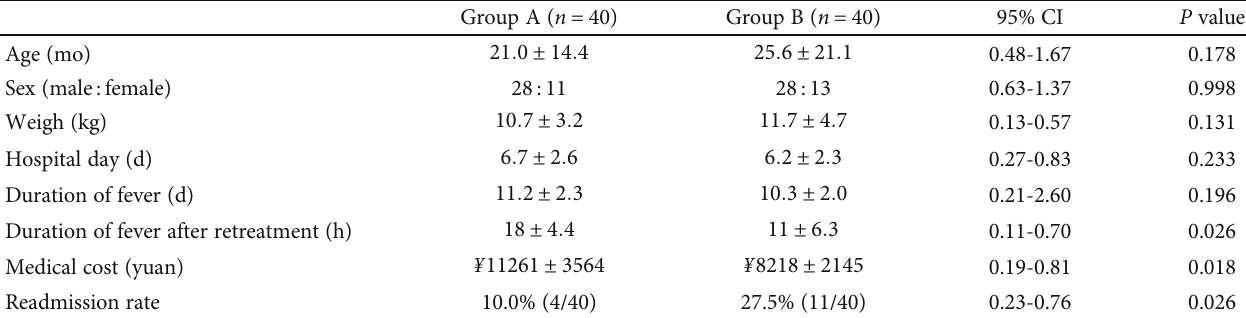
Figure 1: Protocol and results of the treatment in this study. IVIG: intravenous immunoglobulin; CAL: coronary arterial lesion; MPT: methylprednisolone pulse therapy; OM: oral methylprednisolone. Table 1: Age, sex, inpatient day, duration of fever, duration of fever after retreatment, and medical cost in both